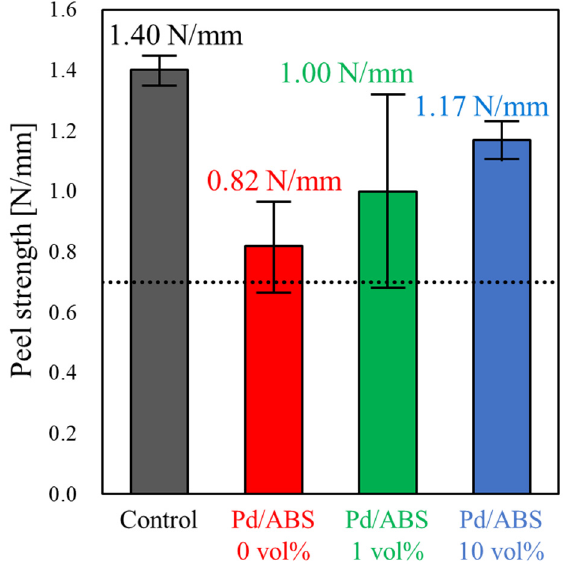
Figure 3. Exterior pictures of Pd/ABS samples after electroless Cu plating: ( a ) Pd/ABS 0 vol%, ( b ) Pd/ABS 1 vol%, and ( c ) Pd/ABS 10 vol%.